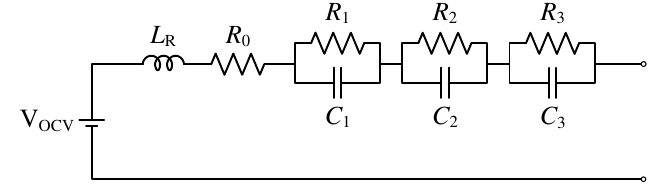
Figure 1. Dynamic battery model with three RC -pairs.